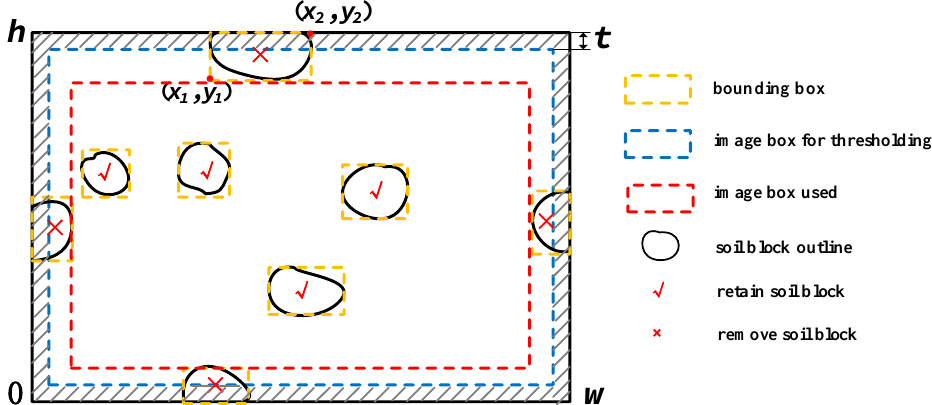
Figure 12. Simple schematic for edge-removal incomplete blocks.